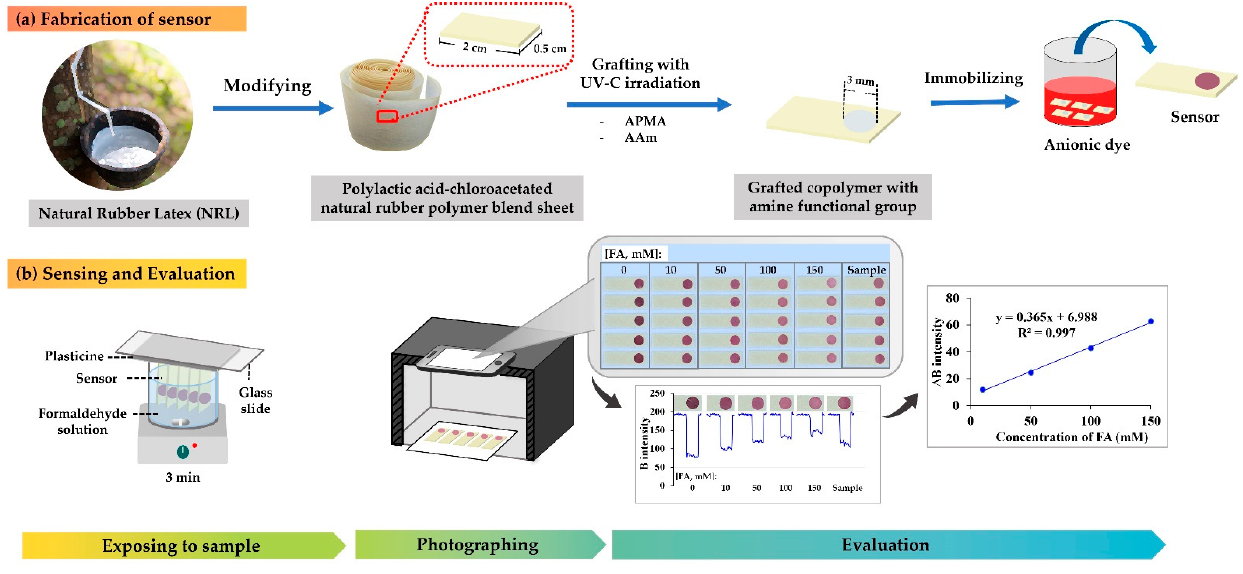
Figure 4. Illustration of the developed sensor for FA assay: ( a ) fabrication and ( b ) sensing and evaluation.